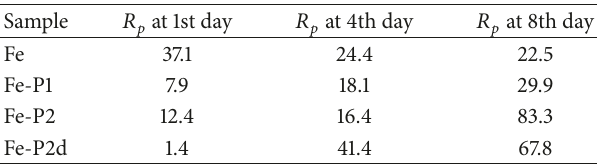
Table 2: Polarization resistance 𝑅 𝑝 (in kOhm) at different durations of corrosion